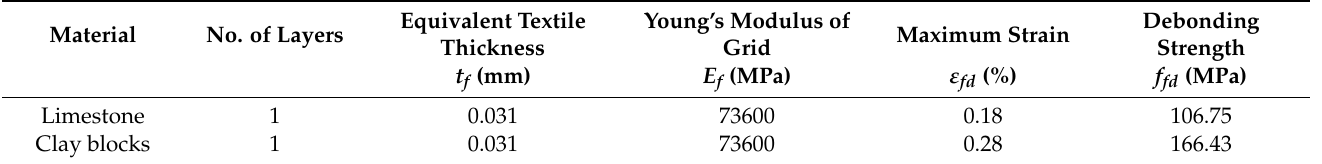
Table 3. Geometric and mechanical parameters of FRCM